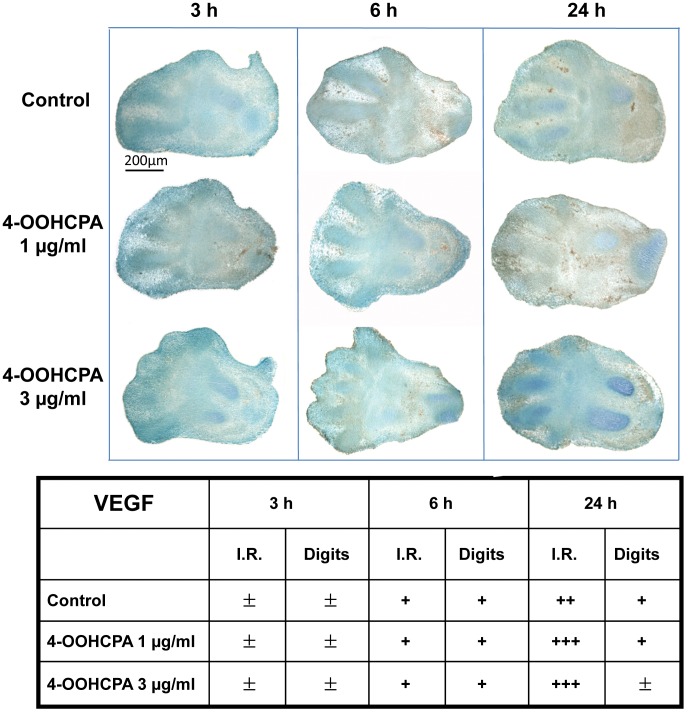
Immunolocalization of VEGF in control and 4-OOHCPA treated limbs.VEGF protein was detected in control limbs in the apical ectodermal ridge and interdigital regions (I.R.) with stronger staining observed at 24 h. Staining was increased in these areas in limbs exposed to either 1.0 or 3.0 µg/ml 4-HOOCPA for 24 h. Four separate replicates were done.